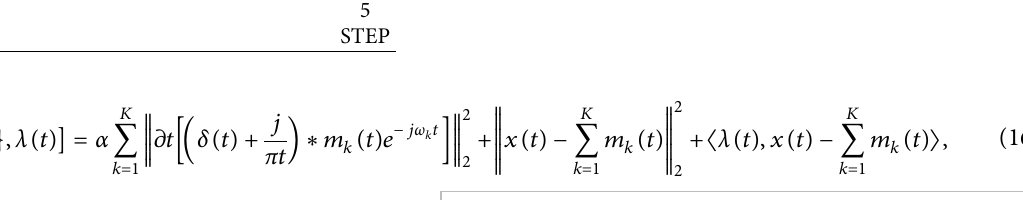
Table 3: Parameter setup used for dynamics simulation. Parameter Setup